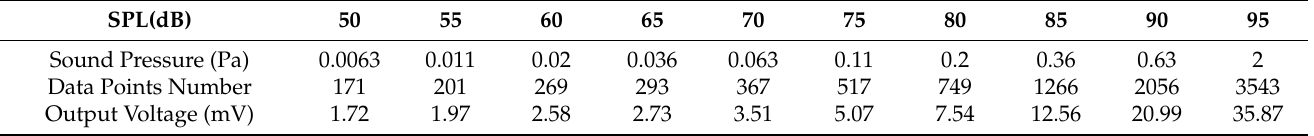
Table 2. Statistical table of the system response to sound data under different decibels.